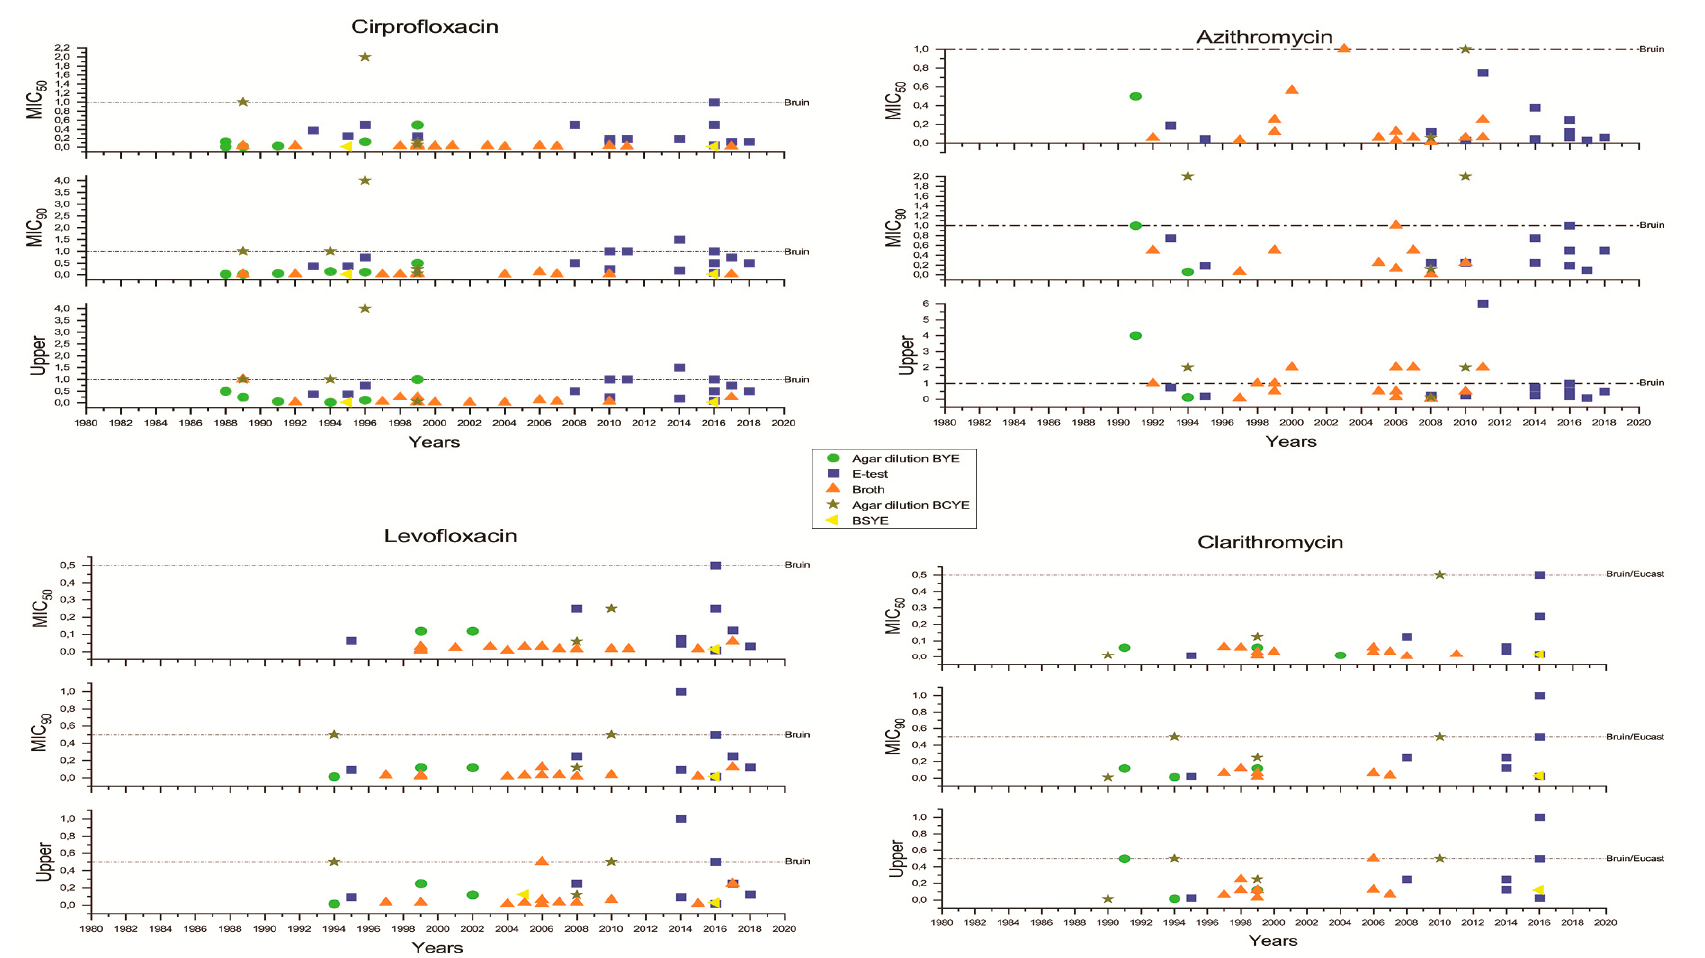
Figure 4. Distribution of MICs of docycycline, erythromycin and rifampicin based on di ff erent methodologies (Agar dilution on BYE, E-test, Broth dilution, Agar dilution on BCYE, and BSYE plating). The epidemiological cut-o ff values proposed by Bruin et al. [29] and by the EUCAST (where available; 32) are shown as dotted horizontal lines.